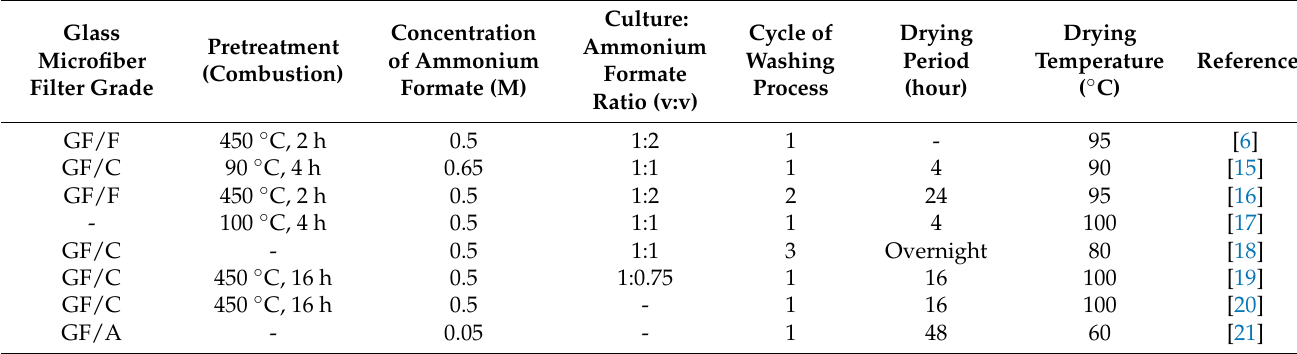
Table 1. Different conditions of several critical parameters in marine microalgal biomass dry weight determination adopted in previous